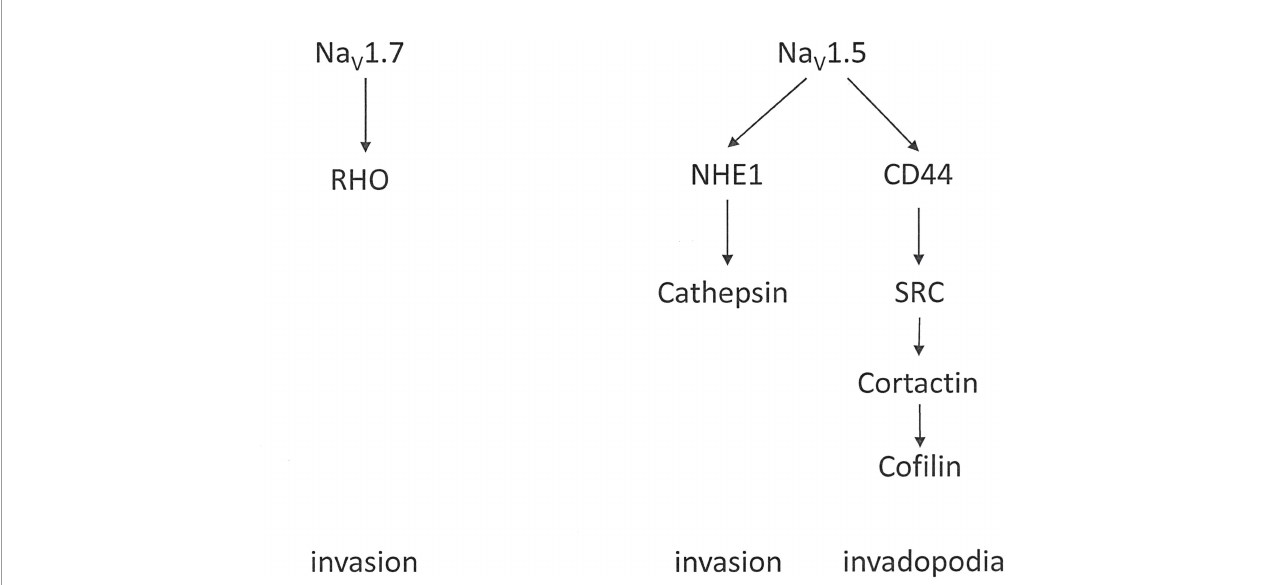
FIGURE 7 | Voltage-gated sodium channels. Contributions by the voltage-gated sodium channels Na V 1.5 and Na V 1.7 to cell